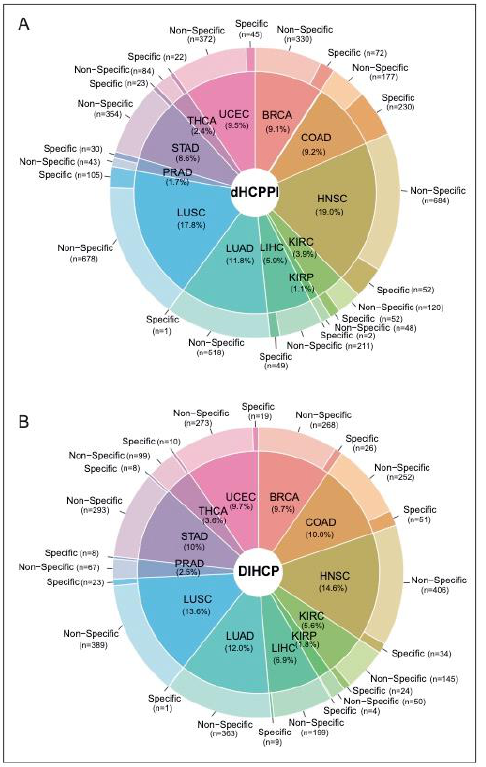
Figure 3. Distribution of differential hallmark of cancer-associated protein – protein interactions and differentially interacting hallmark of cancer proteins. ( A ) The pie-donut chart showing the percentage of specific and non-specific differential hallmark of cancer-associated protein – protein interaction (dHCPPIs) between cancer types. ( B ) The pie-donut chart showing the percentage of specific and non-specific differentially interacting hallmark of cancer proteins (DIHCPs) between cancer types.